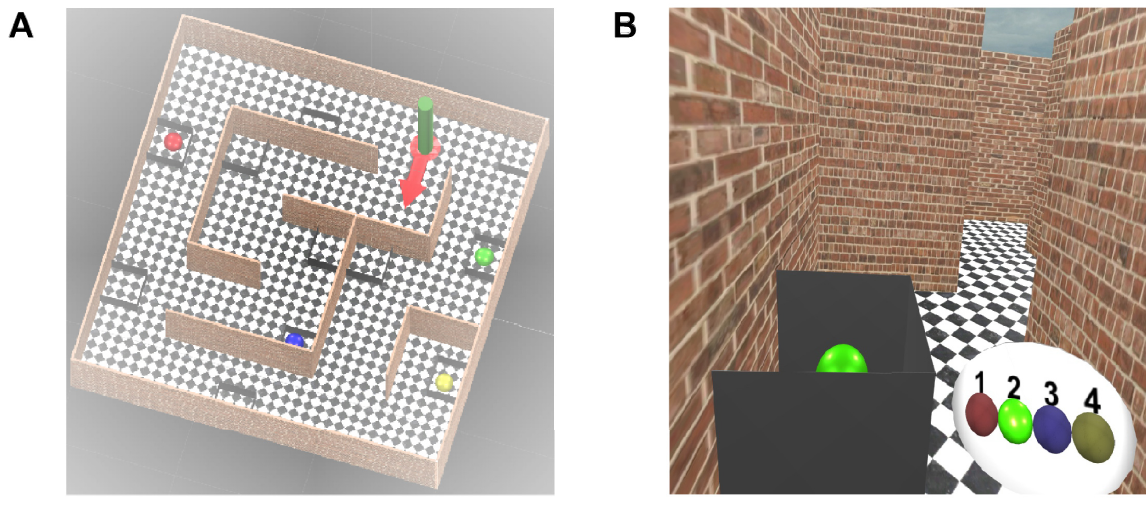
Fig 1. Views of the labyrinth. A) View from above. B) First person view. The green target is visible inside a grey box. The target sequence is shown on the wrist-band in the bottom-right corner and the current target is highlighted (Green). A movie version is included in the (S1 Video) for the Fixed condition.